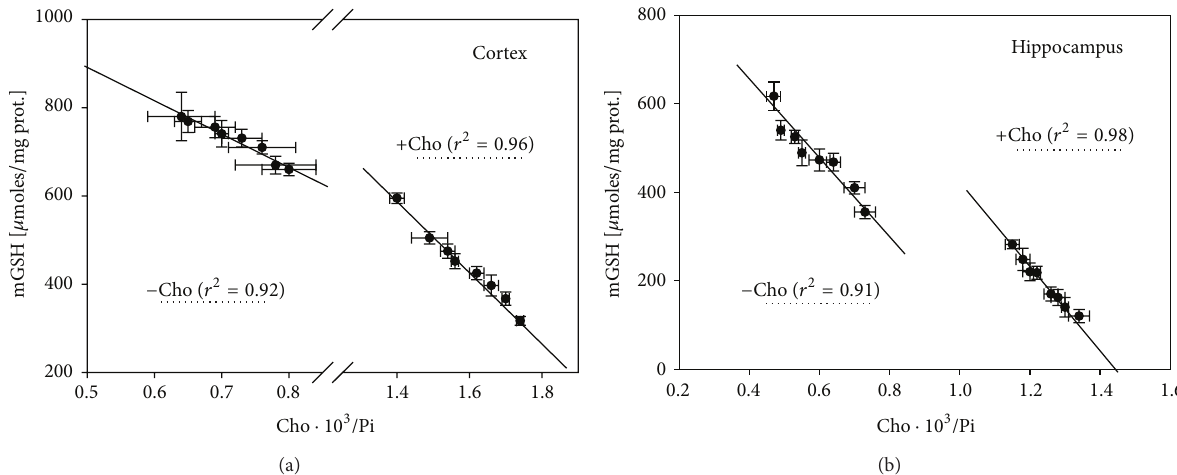
Figure 10: Lineal correlation coefficients for the relationship between mGSH and Cho/Pi ratio in cortex (a) and hippocampus (b) grouped according to two groups of data independently of Cu supplementation, one for rats that did not receive cholesterol ( − Cho) and the other for animals fed on diets supplemented with Cho (+Cho). The values of the 𝑟 2 for each curve adjustment appear in